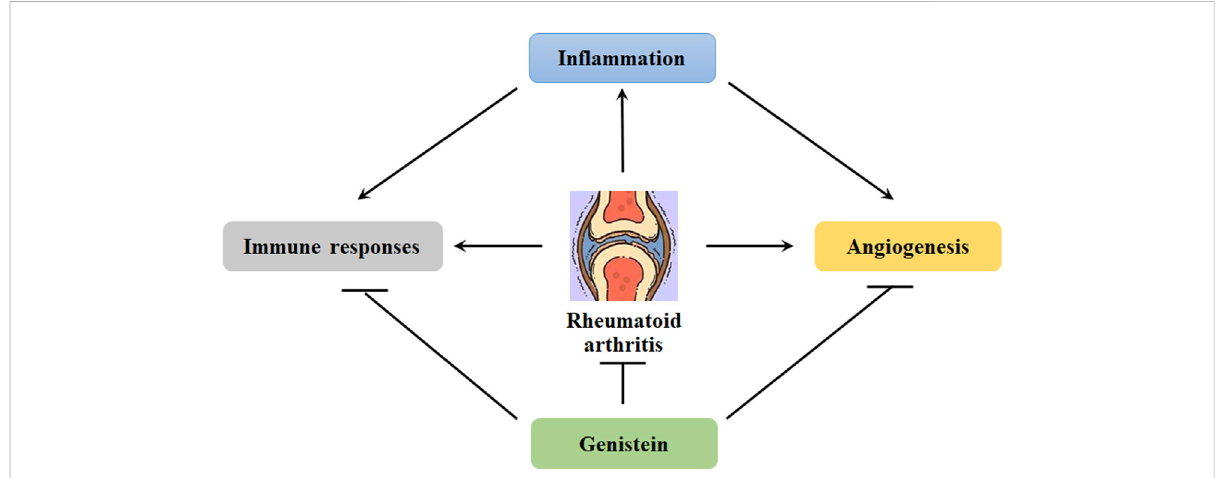
FIGURE 4 Genisteininhibitstheprogressionofrheumatoidarthritis.Chronicin fl ammationcaninduceangiogenesis.Inaddition,in fl ammationalsoinduce immune responses, promoting the transformation of fi broblast-like synoviocytes. These abnormalities can be effectively blocked by genistein, protecting against rheumatoid arthritis